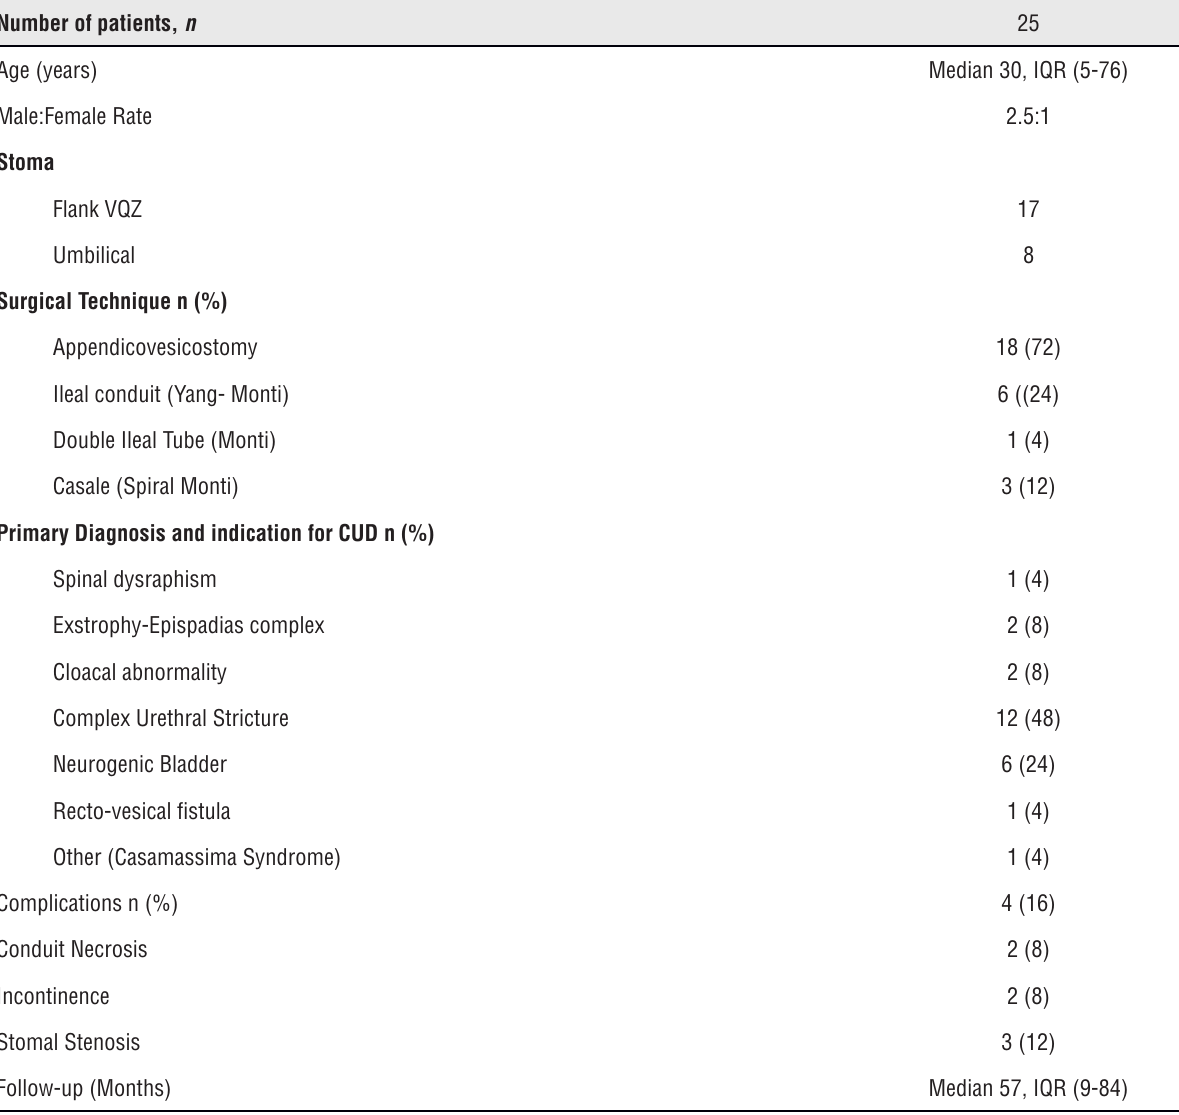
Table 1 - Revision and were managed with indwelling catheters. Number of patients,